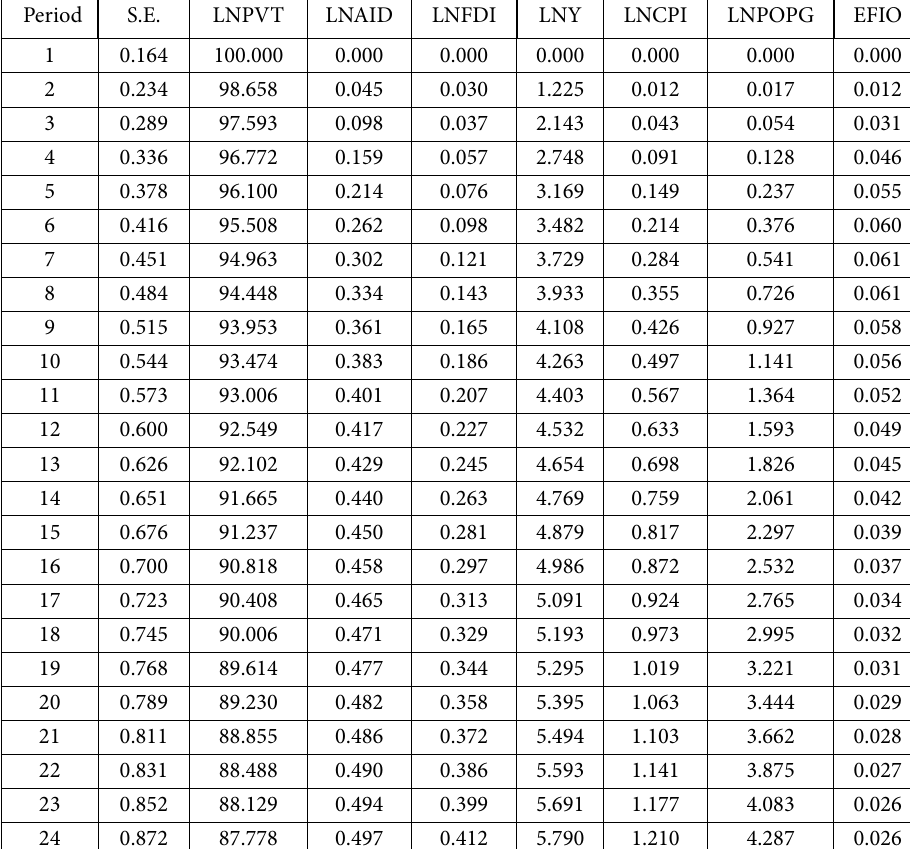
Table 12. Variance decomposition of poverty alleviation Variance Decomposition of poverty alleviation for developing and least developed countries: